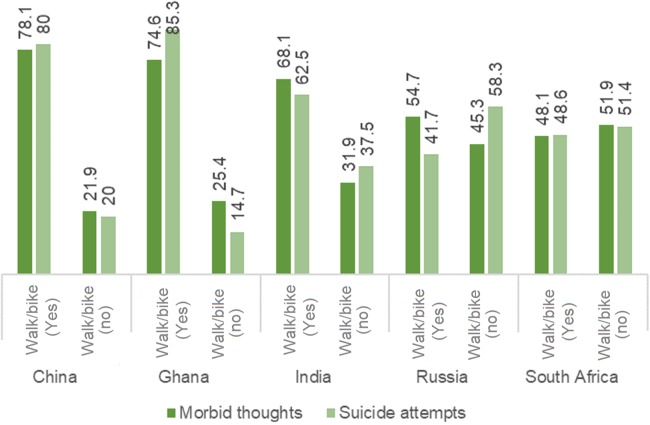
Prevalence of suicidal thoughts and suicide attempts stratified by patterns of walking/biking.